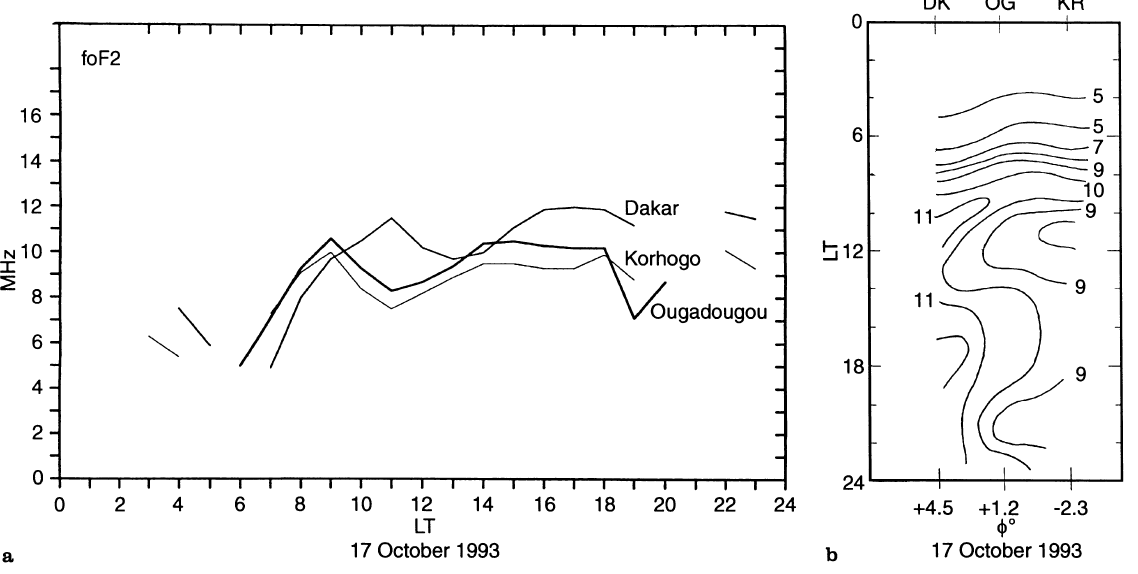
Fig. 6. Example of dome-type event, 17 October 1993. a f oF2(UT) curves, b corresponding f oF2